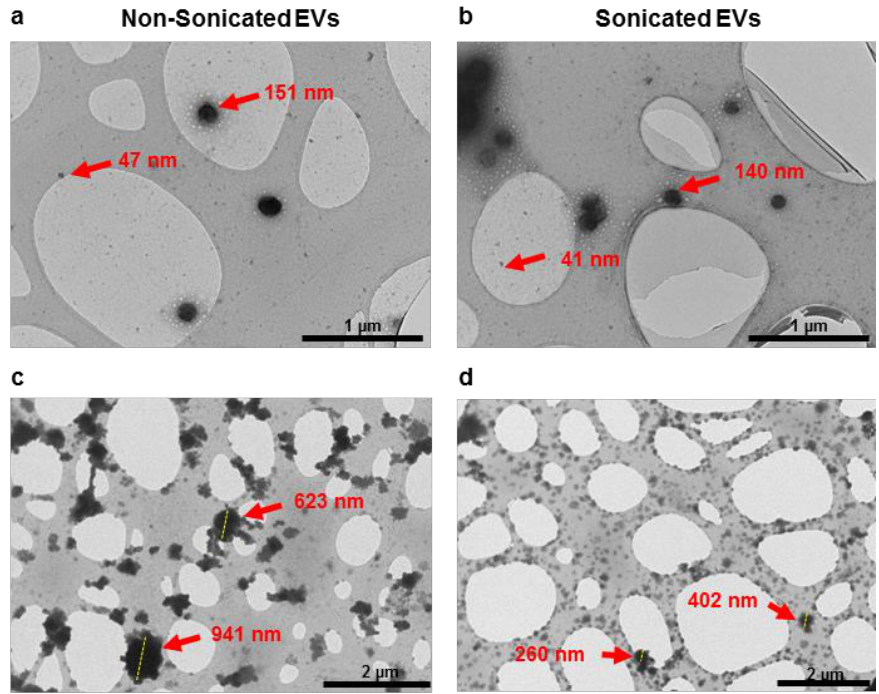
Figure 1. TEM imaging showing particle distribution of non-sonicated ( a , c ) and sonicated ( b , d ) EV isolates observed at higher magnification (≥26.5k, a , b ) and lower magnification ( 11.5k, c , d ).